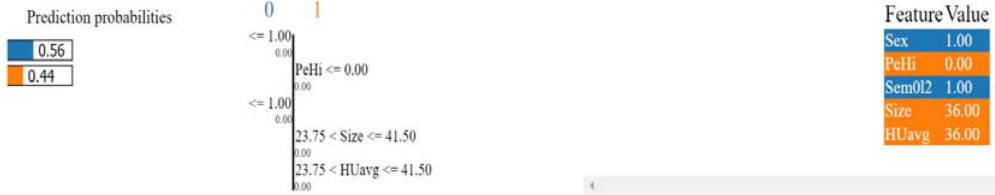
Figure 10. LIME explainability representation for the case study .